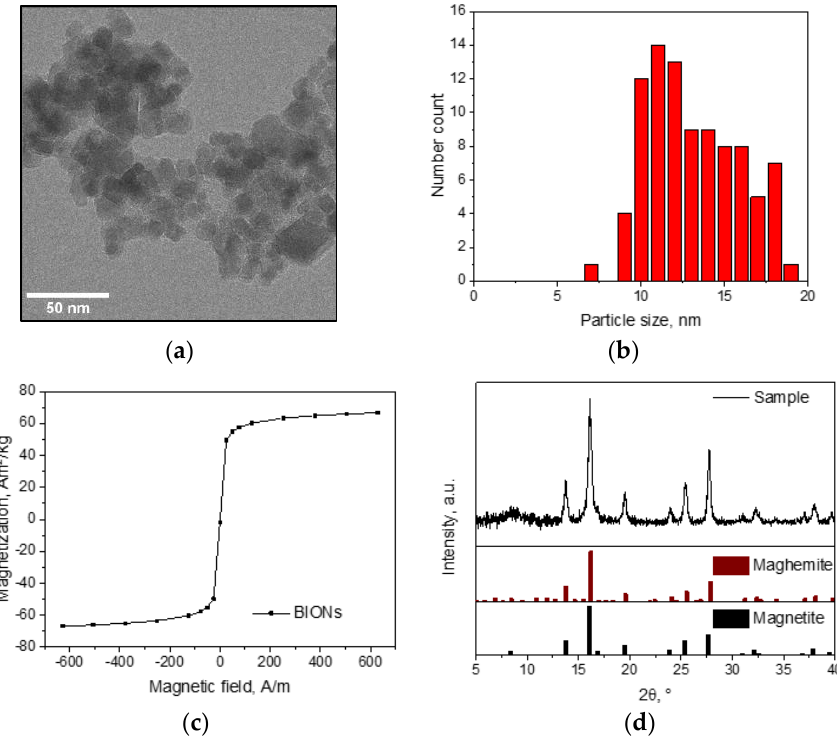
Figure 1. Characterization of the self-synthesized BIONs. ( a ) Transmission electron microscopy image of the nanoparticles; ( b ) particle size distribution histogram from TEM; ( c ) saturation magnetization and ( d ) XRD-spectra (pure maghemite and magnetite crystal phases are added as reference).